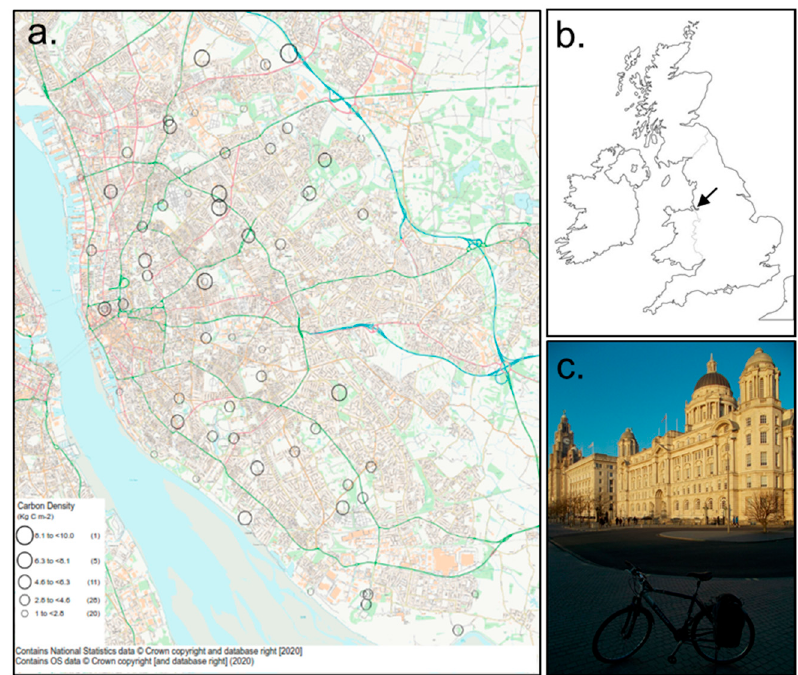
Figure 1. ( a ) Sample locations, selected by free survey, displaying the carbon (C) density of soils ( n = 92). ( b ) The location of the study area within the UK (shown not to scale) and ( c ) the difficulty in locating soils in some areas due to the extent of sealed surfaces.